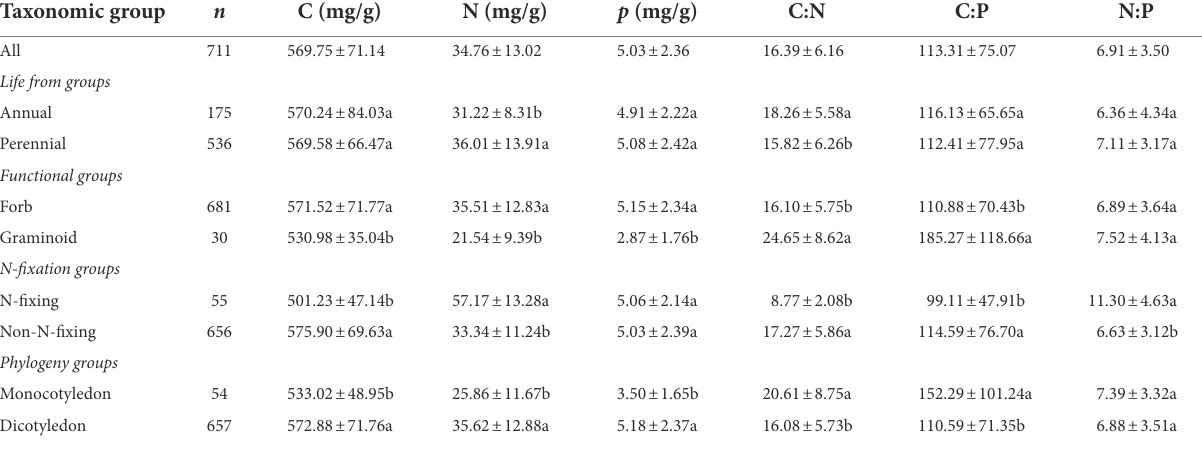
n represents the number of samples. Different letters denote significant differences at the 0.05 level.